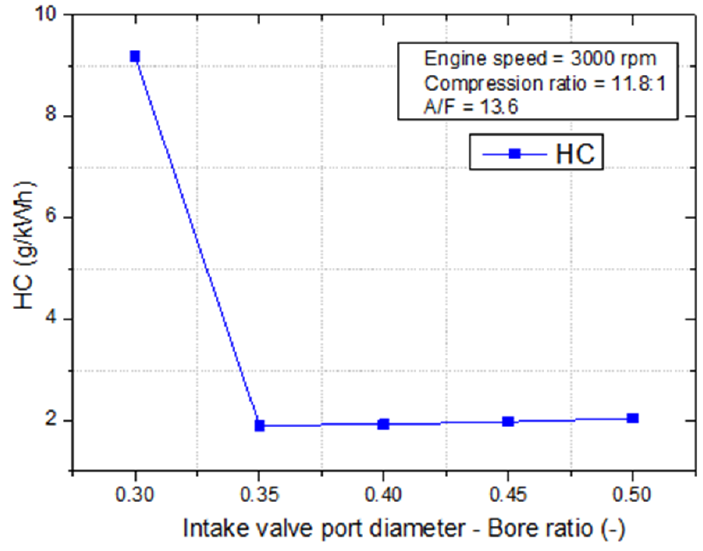
Figure 14. HC trend versus IPD/B.